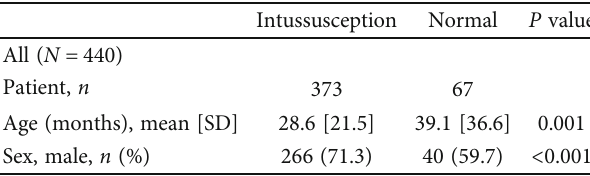
Table 1: Patient baseline